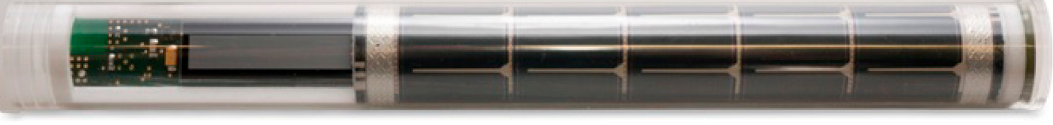
Figure 1. Fully assembled Scipio